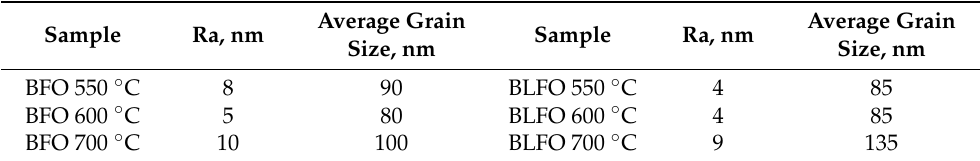
Table 2. Surface parameters of BiFeO 3 and Bi 0 . 9 La 0.1 FeO 3 sol–gel films annealed at different